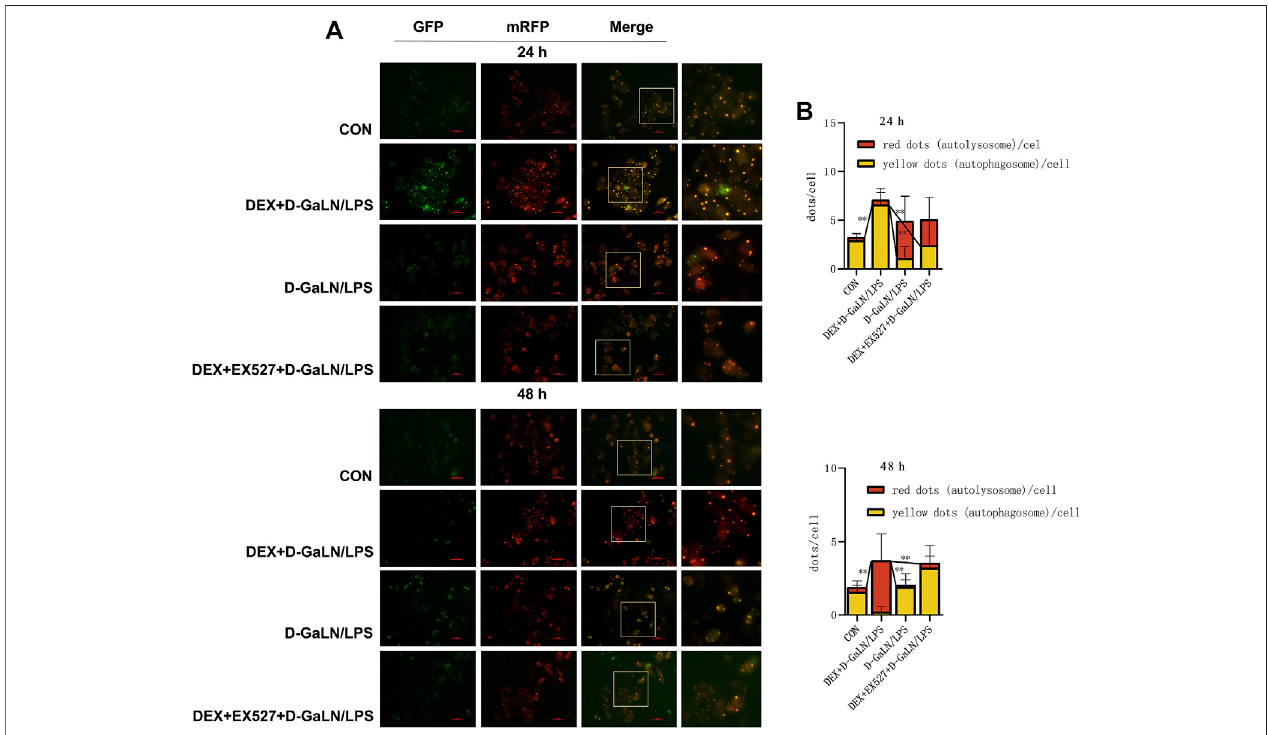
FIGURE 7 | EX527 inhibited DEX-induced autophagy fl ux in D-GalN/LPS-treated L-02 hepatocytes. (A) Fluorescence images of the mRFP-GFP-LC3 in L-02 cells showing the autophagy fl ux at the indicated time points. (B) Mean number ofautophagosomes (yellow puncta in the merged images) and autolysosomes (red puncta in the merged images) per cell. Error bars on the bar graphs represent the mean ± SD. ** p <